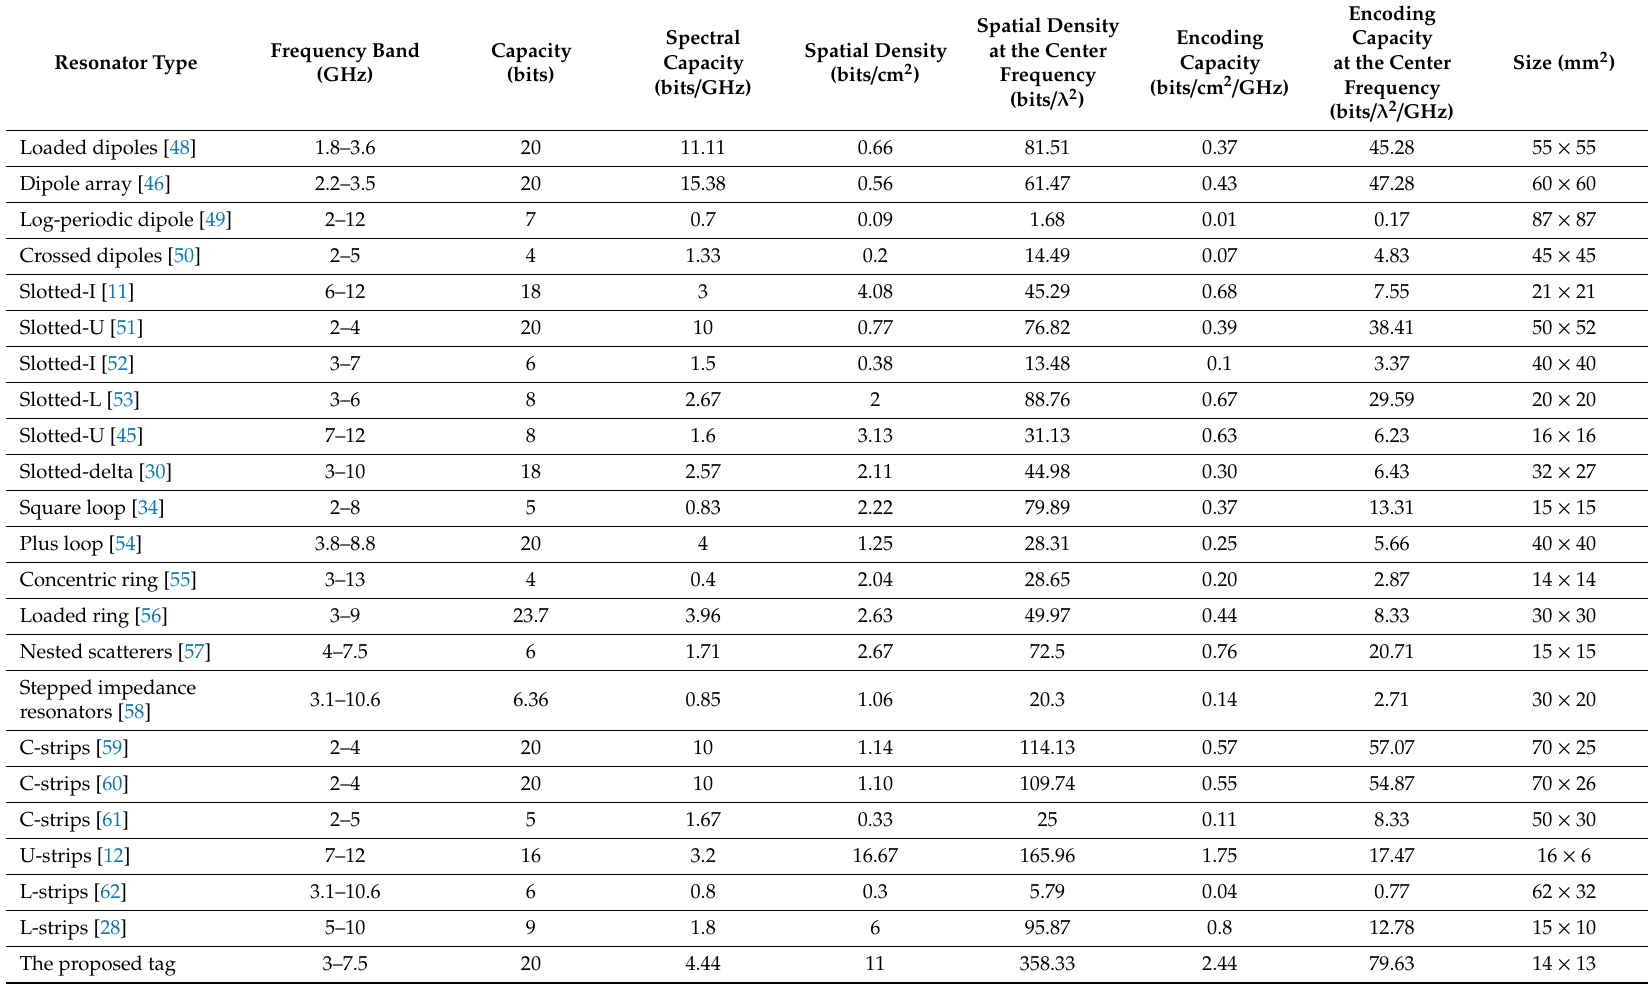
Table 5. Comparison between the proposed tag and di ff erent backscatter-based chipless RFID